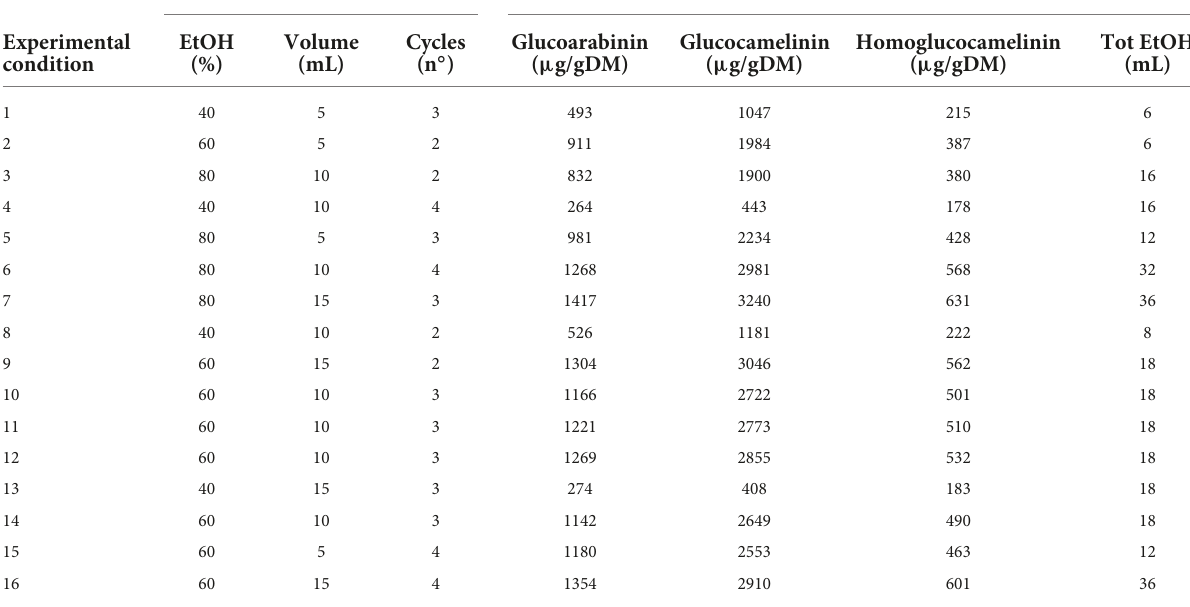
TABLE 1 Experimental conditions of the response surface design and experimental values of the response variables. Independent